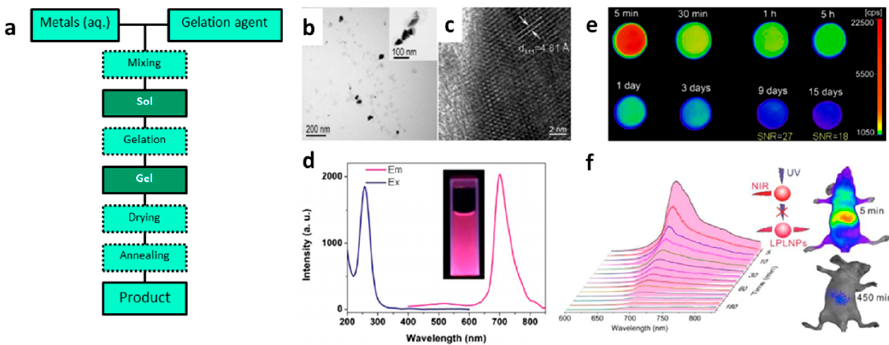
Figure 11. ( a ) Schematic flowchart of SGS. ( b ) TEM, ( c ) high-resolution TEM, ( d ) excitation (blue curve, left) emission at 700 nm) and emission (red curve, right) excitation at 254 nm) spectra of the aqueous dispersion of the material, ( e ) afterglow emission collected at different times after turning off UV excitation, and ( f ) in vivo NIR afterglow imaging. Material: Zn 2.94 Ga 1.96 Ge 2 O 10 :Cr 3 + ,Pr 3 + , λ exc = 254 nm and λ em = 700 nm. Reprinted with permission from [219]. Copyright (2013) American Chemical Society.